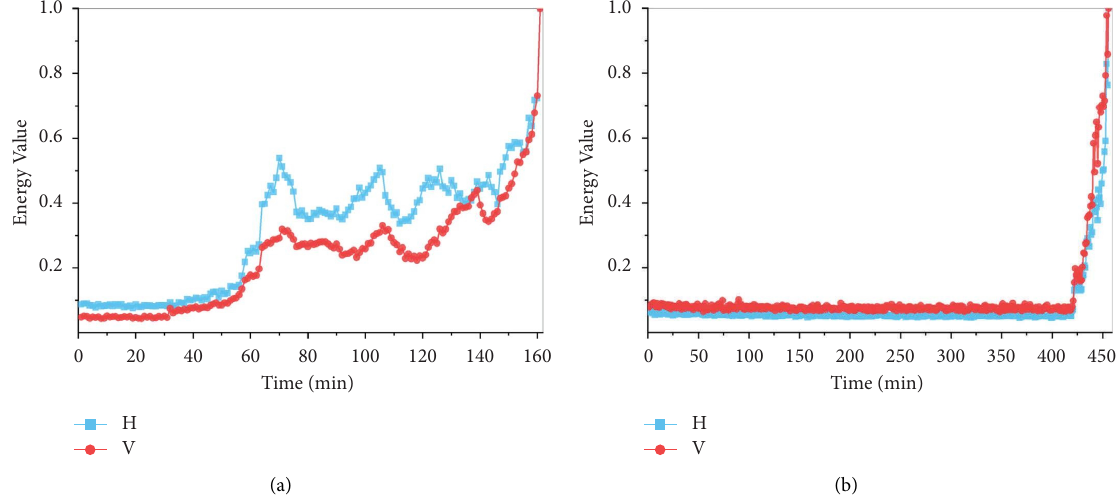
Figure 8: Te bearing spectrum energy. (a) Bearing 1-2. (b) Bearing